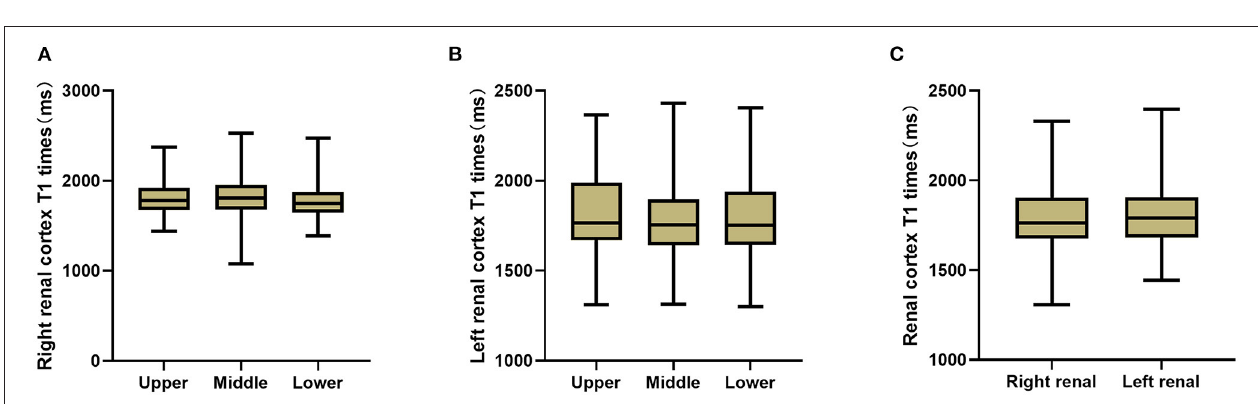
FIGURE 3 | T1 comparison between each two sub-regions of right kidney (A) and left kidney (B) , and between bilateral kidneys (C) . No significant T1 difference of the renal cortex was found ( P > 0.05).